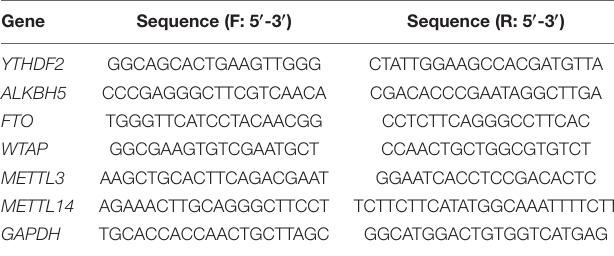
TABLE 1 | The qRT-PCR